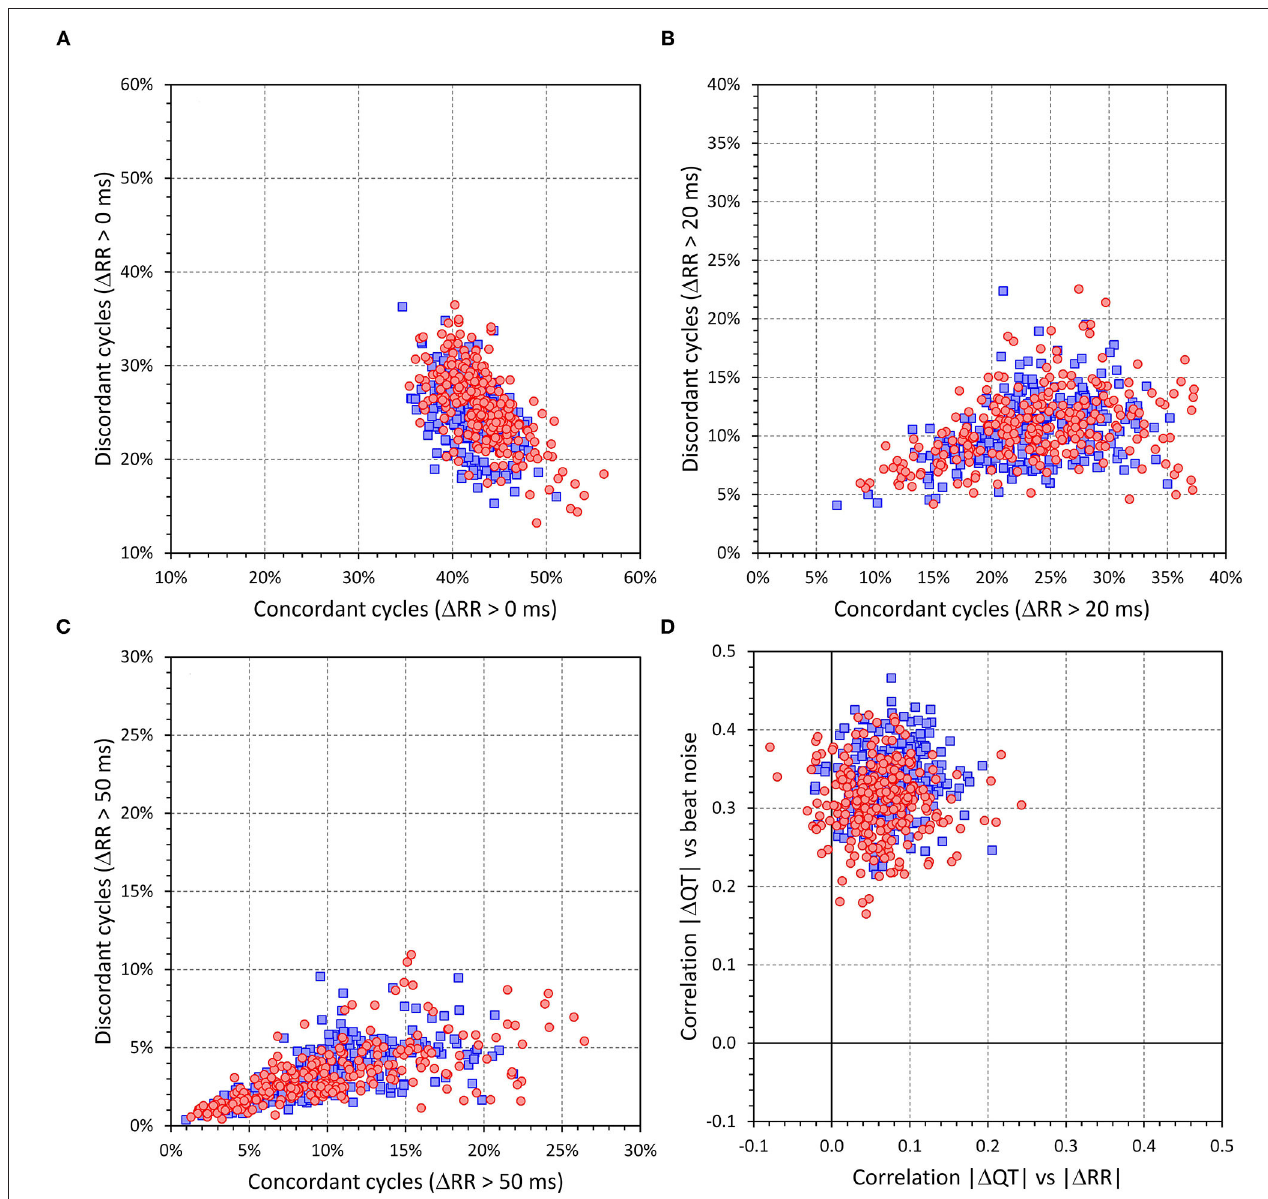
FIGURE 4 | The upper left (A) shows a scatter diagram between intra-subject frequencies of concordant and discordant beats (the frequencies calculated as the proportions of all accepted beats for the given subject). The upper right (C) and lower left (B) show the same for concordant and discordant beat frequencies when considering only the beats for which | 1 RR| > 20ms and | 1 RR| > 50ms, respectively. The bottom right (D) shows a scatter diagram between intra-subject correlations | 1 QT| vs. | 1 RR| and | 1 QT| vs. beat noise. In all panels, red circles and blue squares correspond to females and males,